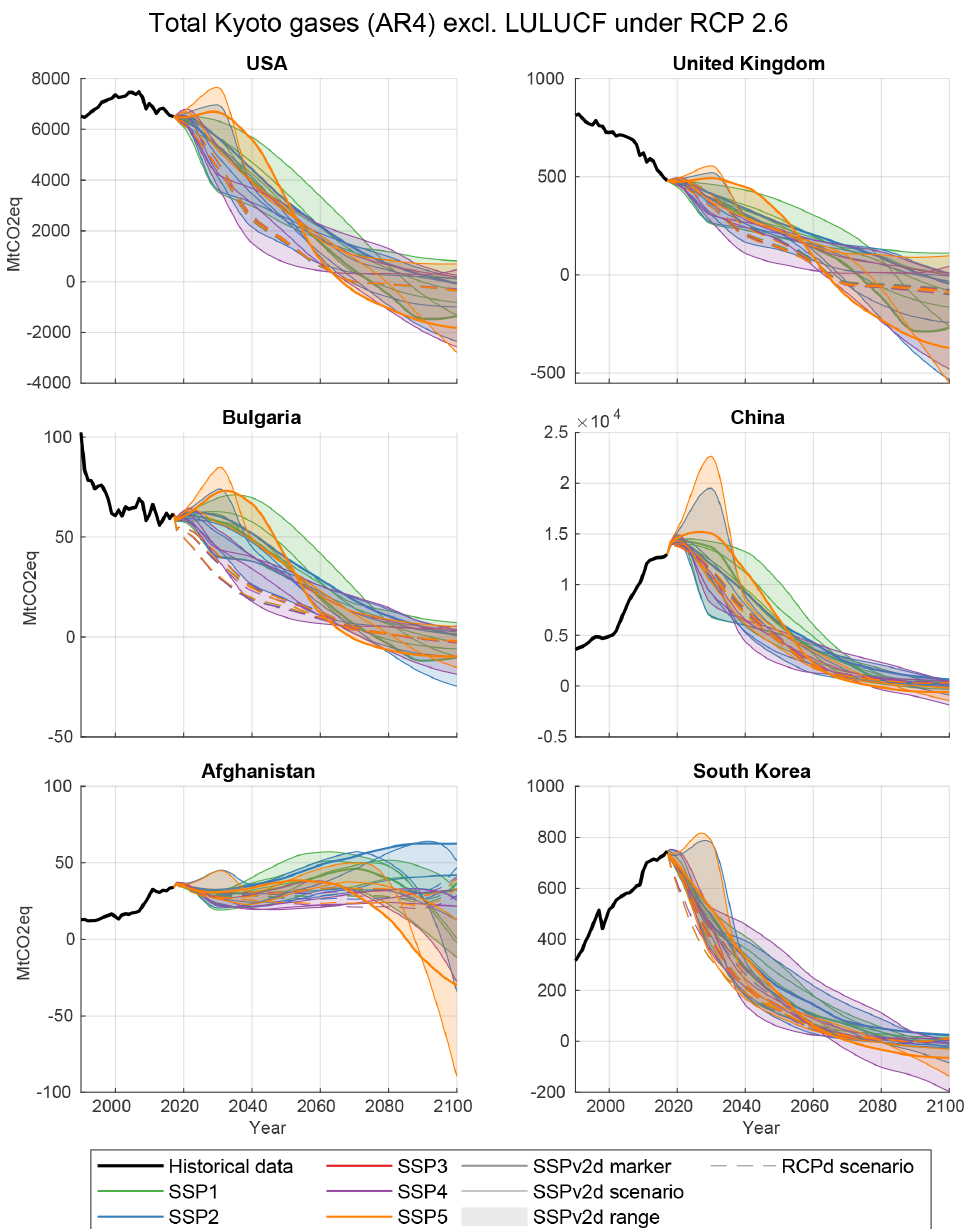
Figure 8. Results for RCP2.6 and all SSPs for both the RCPd and SSPv2d scenarios. Countries from the regions of the OECD and Asia. For the OECD region the differences in country pathways are driven by differences in regional pathways, not by the socio-economic development leading to very similar pathways for the countries in the region. In the Asia region the socio-economic development is more diverse and strongly influences the resulting country emission pathways. The most prominent example is the high negative emissions for Afghanistan in SSP5 driven by the very high GDP growth rates (Fig. 6). Note that South Korea is in the OECD region for the WITCH–GLOBIOM